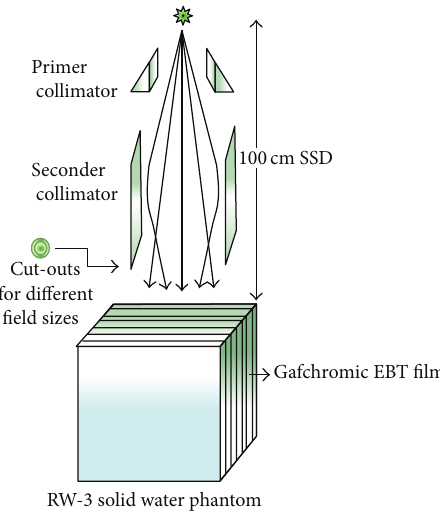
Figure 1: Solid water phantom setup used for isodose distribution measurements. Gafchromic films were aligned parallel to the elec- tron beam in solid water